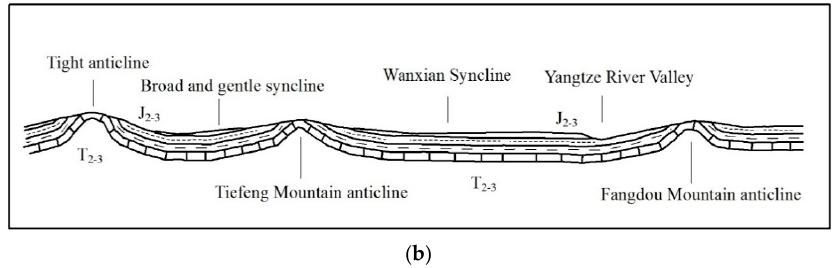
Figure 8 . Geological maps of the study area. ( a ) Geological and tectonic sketch; ( b ) a schematic geological cross-section.